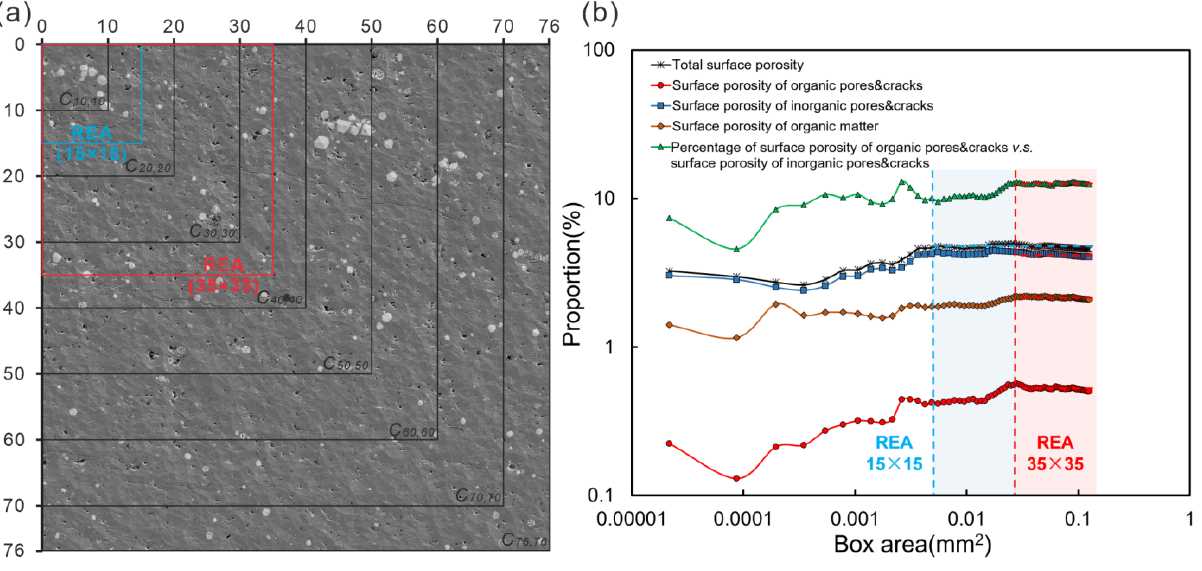
Figure 3. ( a ) Principle of REA determination, blue box is regular REA, red box is stringent REA; ( b ) the variation of surface porosity for the four pore types versus box area.